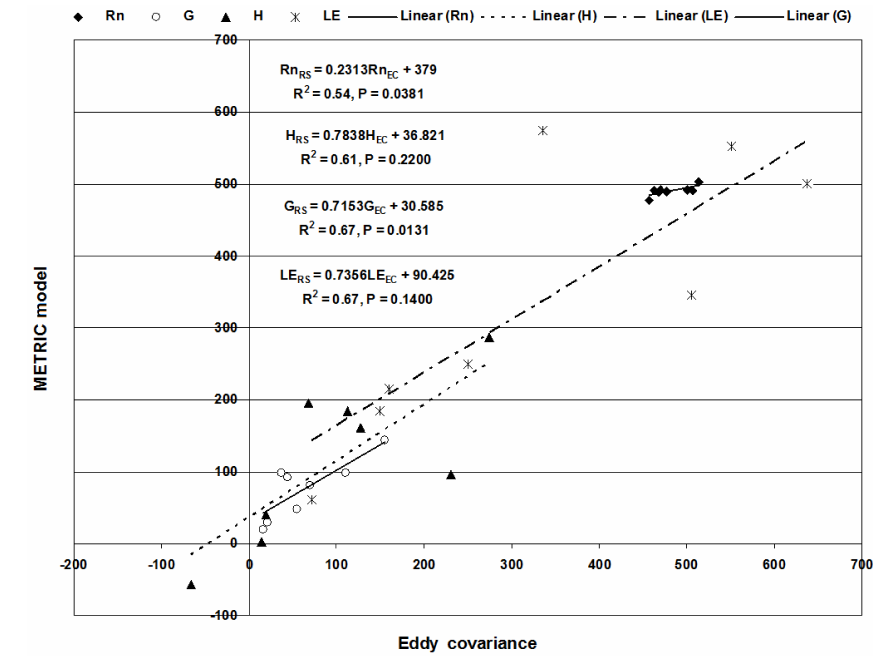
Figure 5. The relationship between EB components (Wm − 2 ) measured by the METRIC algorithm and the EC